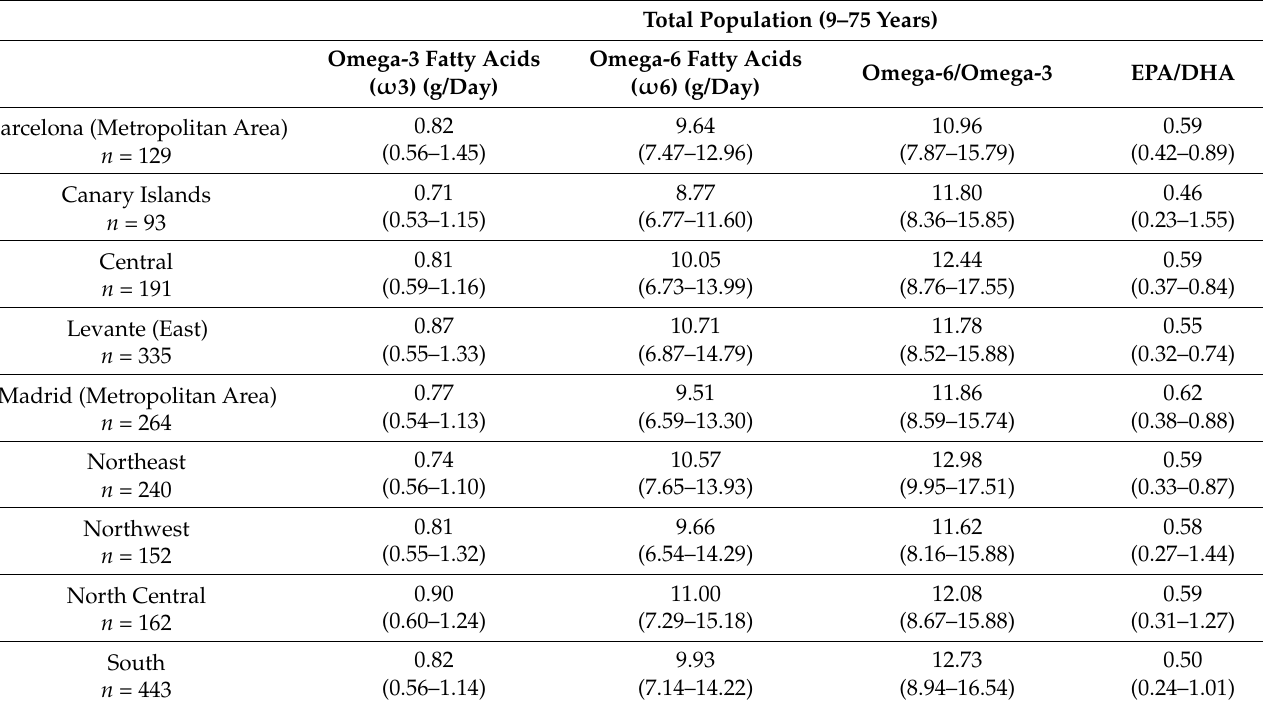
Table 8. Omega-3 and omega-6 fatty acid dietary intake and ratios according to geographical areas (Nielsen regions) of residence among the ANIBES Study